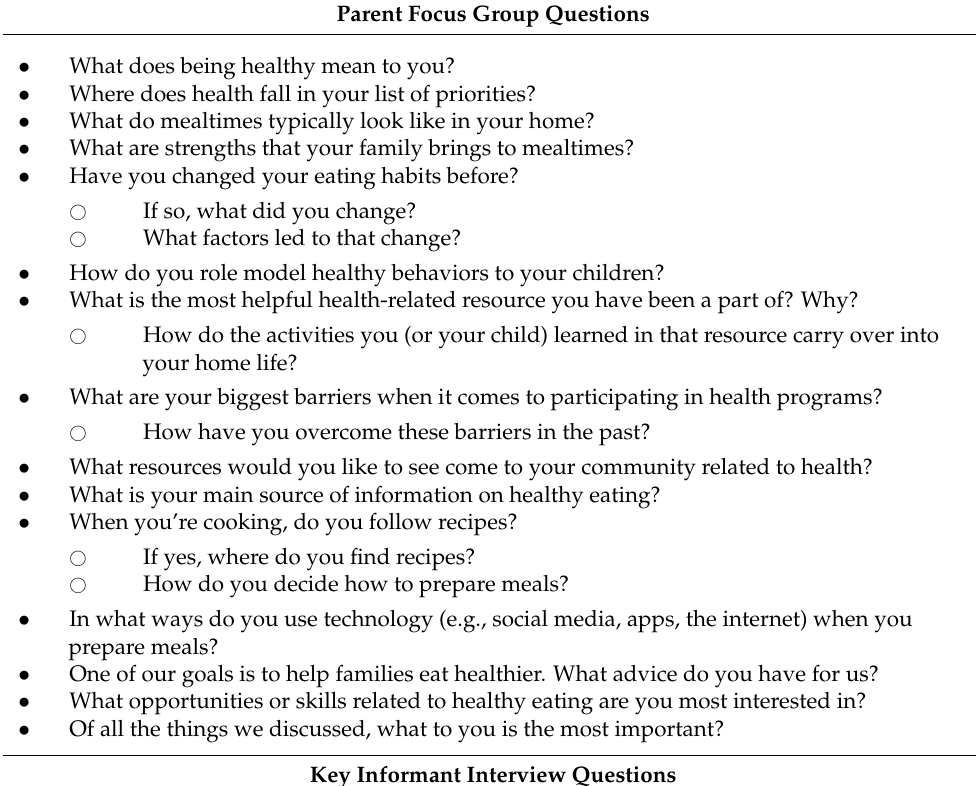
Table 1. Focus groups and key informant interview